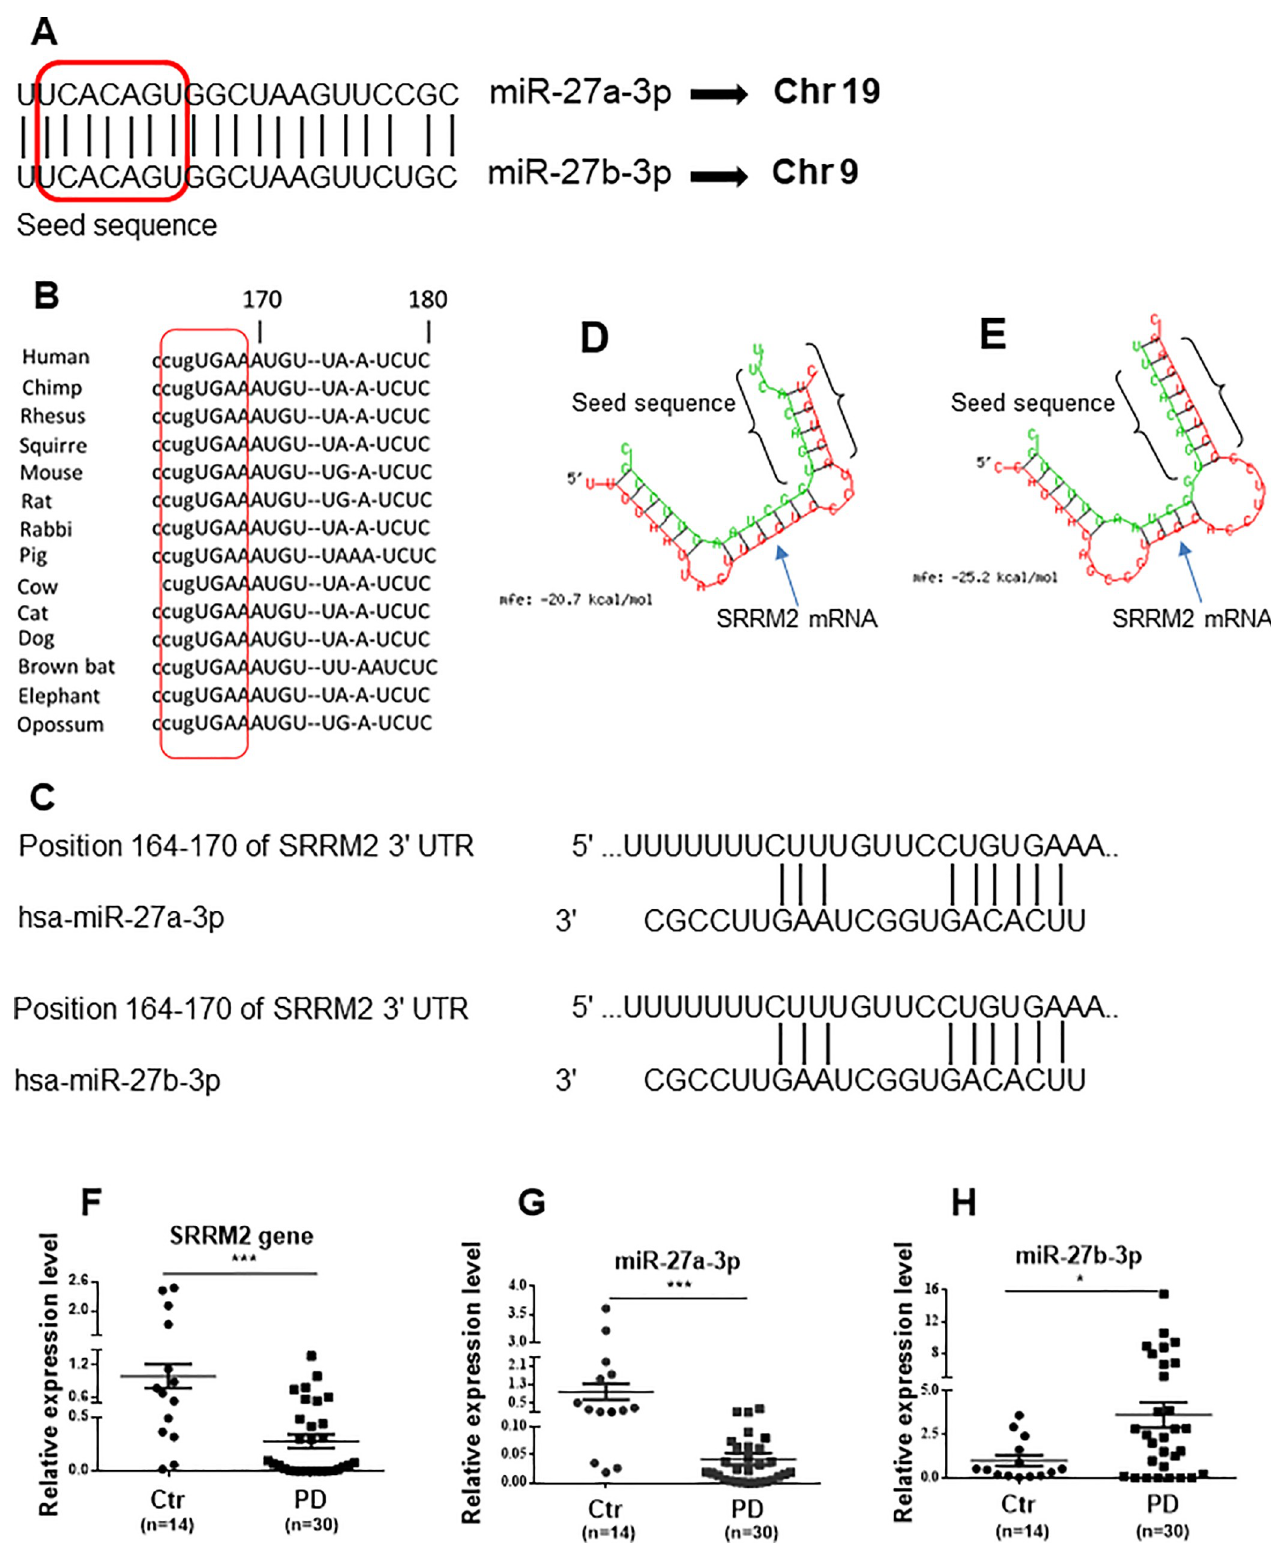
Fig 2. Expression levels and sequences of miR-27a/b-3p and SRRM2 . (A) miR-27a-3p and miR-27b-3p share similar functional seed sequence with only one nucleotide difference. (B) A conserved region in SRRM2 of several species responsible for binding to miR-27a-3p and miR-27b-3p. (C) The binding prediction